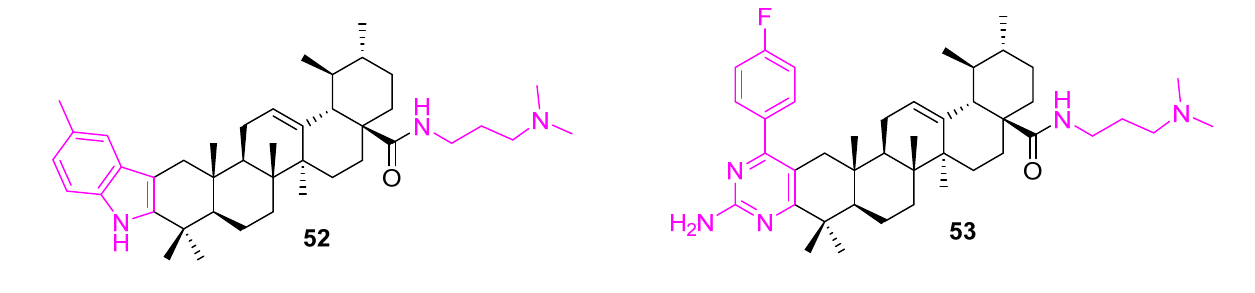
Figure 36. Structure of 52 , 53 .